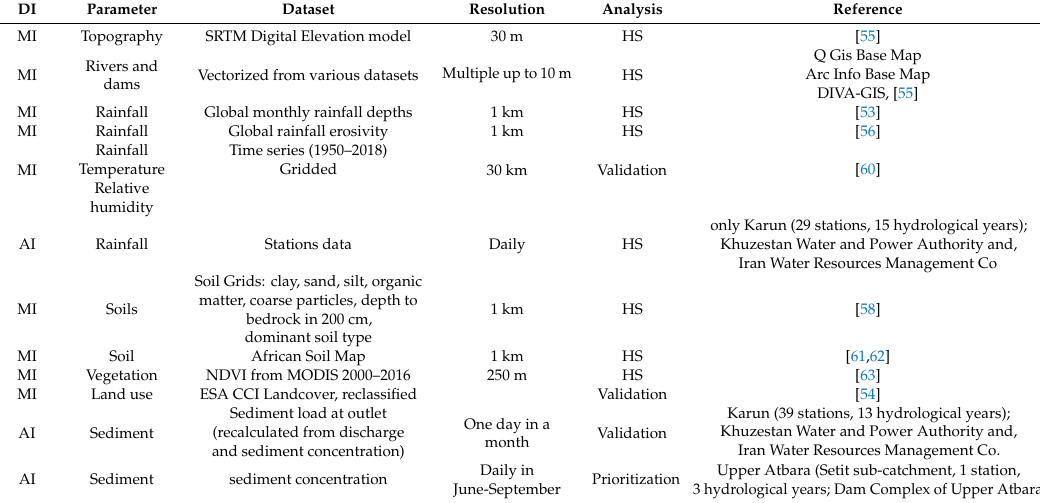
Table 2. Datasets in minimum and accessible